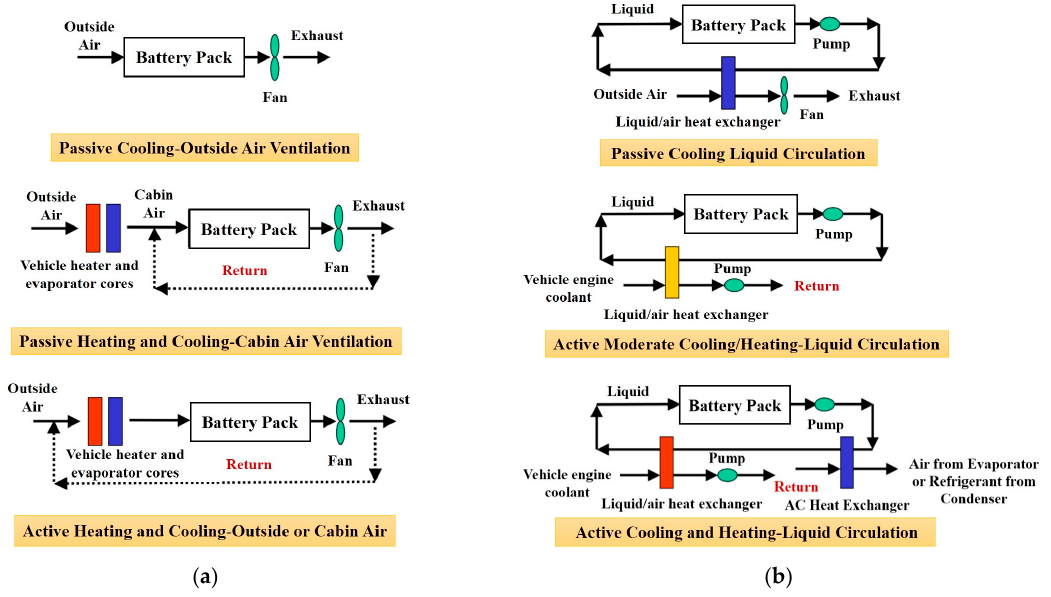
Figure 4. General schematic of BTMS using air and liquid. ( a ) Three air BTM methods; ( b ) Three liquid BTM methods.